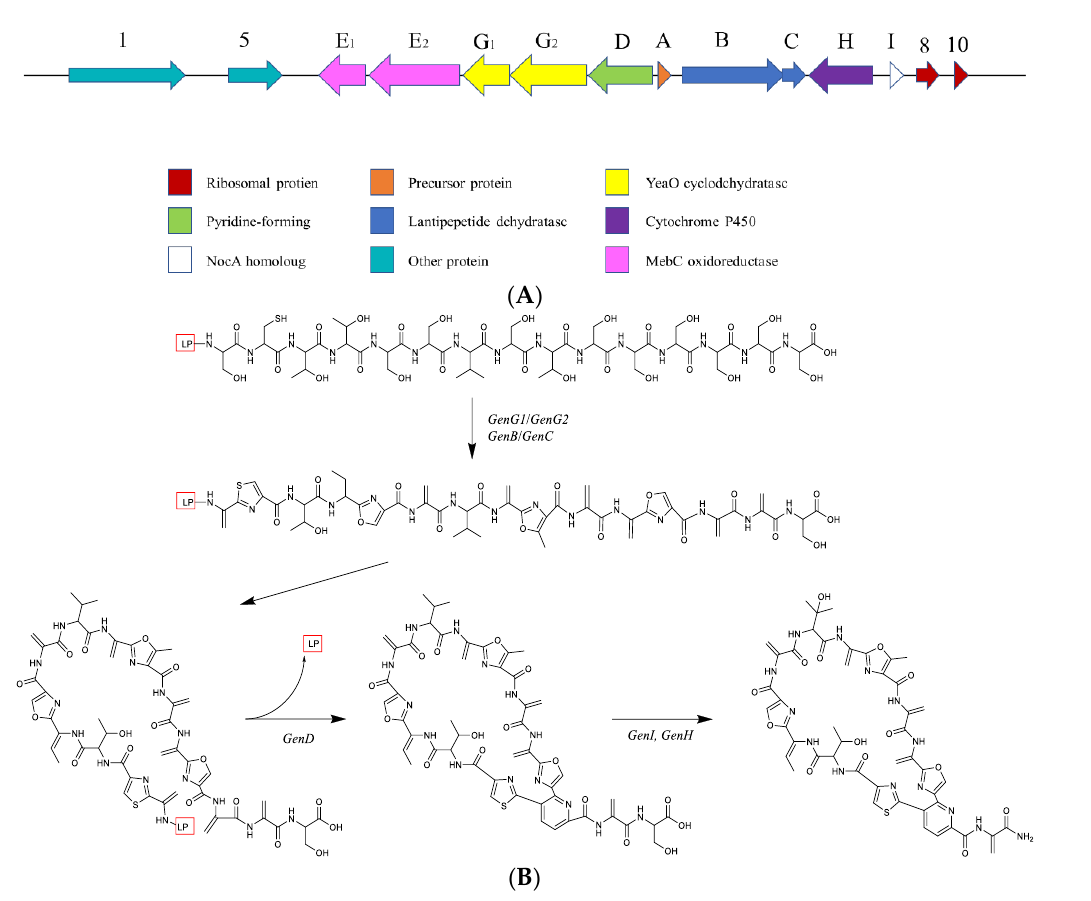
Figure 15. ( A ) The gene clusters of Streptomyces sp. YIM130001. ( B ) The biosynthetic pathway of geninthiocin B [28].